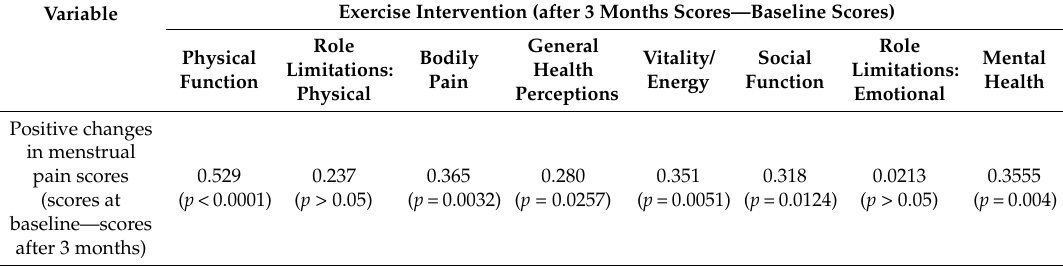
Table 4. Correlation of score changes in the 8 scales of the SF-36 and menstrual pain scores between baseline and after 3 months yoga exercise